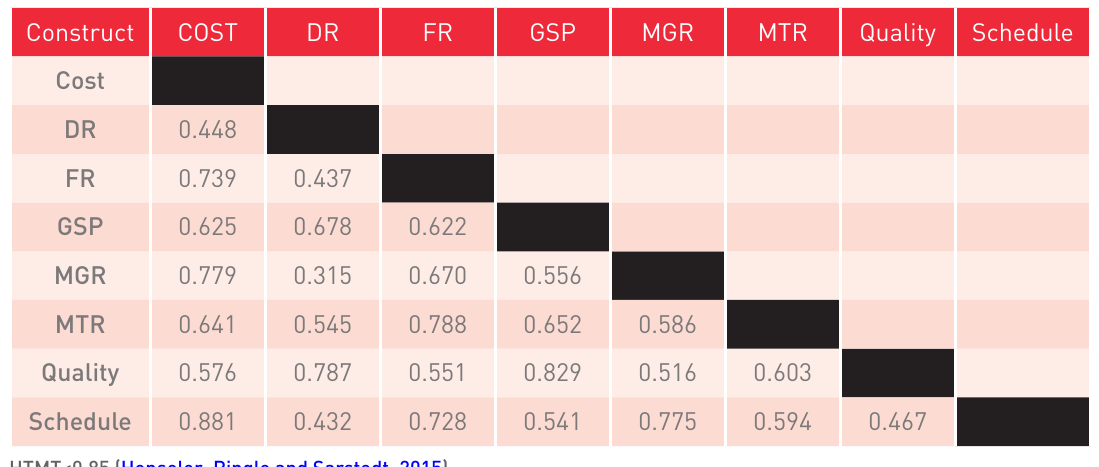
Heterotrait-Monotrait Ratio